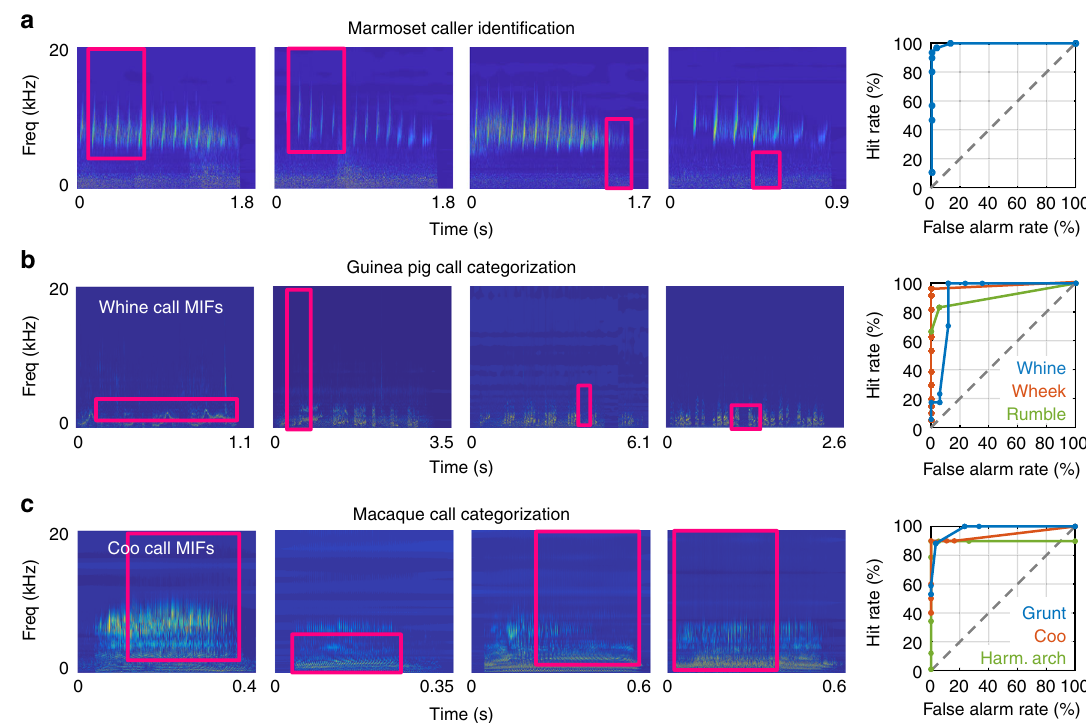
Fig. 10 The applicability of MIF-based classi fi cation for other auditory tasks. The top four MIFs and ROC curves for: a marmoset caller identi fi cation (twitter calls), b Guinea pig call classi fi cation (MIFs for whine calls shown). Colors are: blue — whine, red — wheek, green — rumble. c Macaque call classi fi cation (MIFs for coo calls shown). Colors are blue — grunt, red — coo, green — harmonic